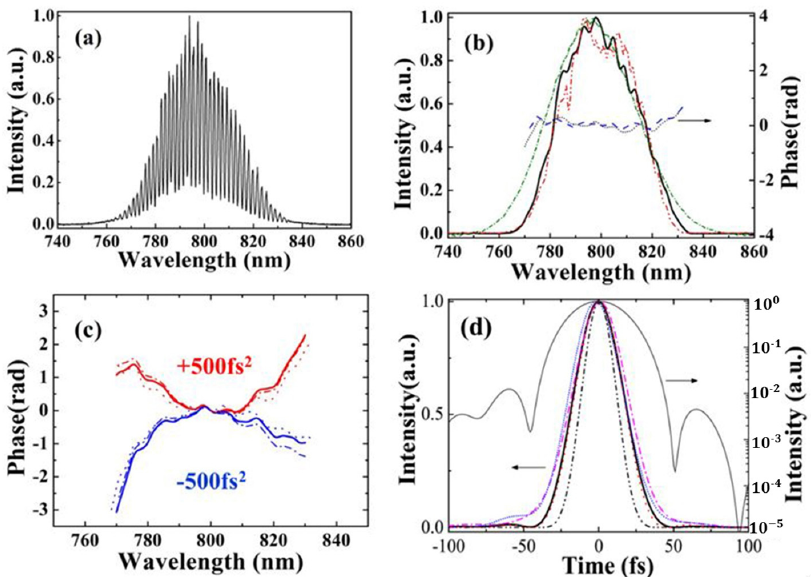
Figure 14. ( a ) Original measured spectral interferogram obtained using the TG-SRSI method. ( b ) Measured spectra of the TG signal (green dash-dotted line) and the testing pulse (red dash-dot-dotted line), the reconstructed spectrum of the testing pulse (solid black line), and the spectral phase obtained by TG-SRSI (gray dotted line) and Wizzler (blue dashed line). ( c ) Spectral phase obtained by TG-SRSI (solid lines), Wizzler (dotted lines), and calculation (dash-dotted line) when GDDs of 500 fs 2 (up and red line) and − 500 fs 2 (down and blue line) were introduced into the testing pulse. ( d ) Reconstructed temporal profile of the testing pulse after adding 0 fs 2 (thick and thin black solid lines), 500 fs 2 (magenta dash-dotted line), and − 500 fs 2 (blue dotted line), and the FTL temporal profiles of the testing pulse (red dotted line) and the TG signal (black dash-dot-dotted line).